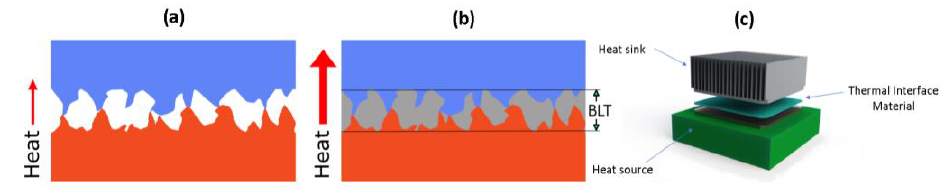
Figure 1. Working principle of a TIM: ( a ) the heat source/heat sink interface without TIM; ( b ) the same interface with a TIM filling the voids within the bond line thickness (BLT) region; ( c ) TIM application in a CPU.